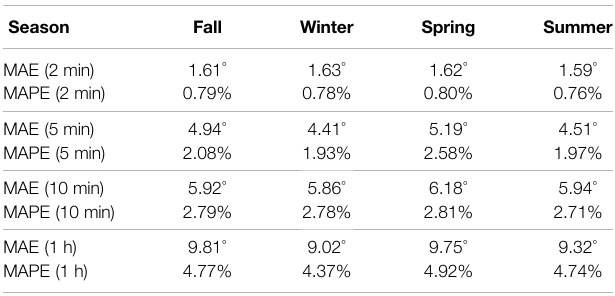
TABLE 4 | Angular prediction error at four